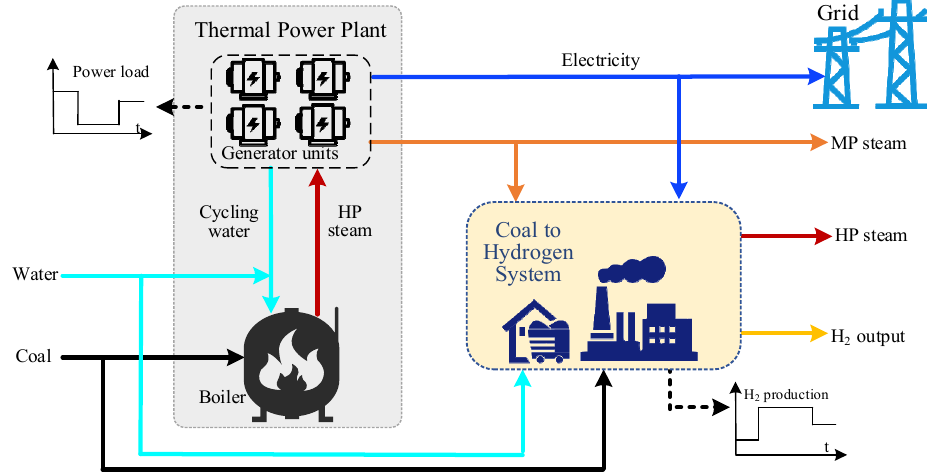
Figure 1. An integrated scheme of a thermal power plant and CtH system.